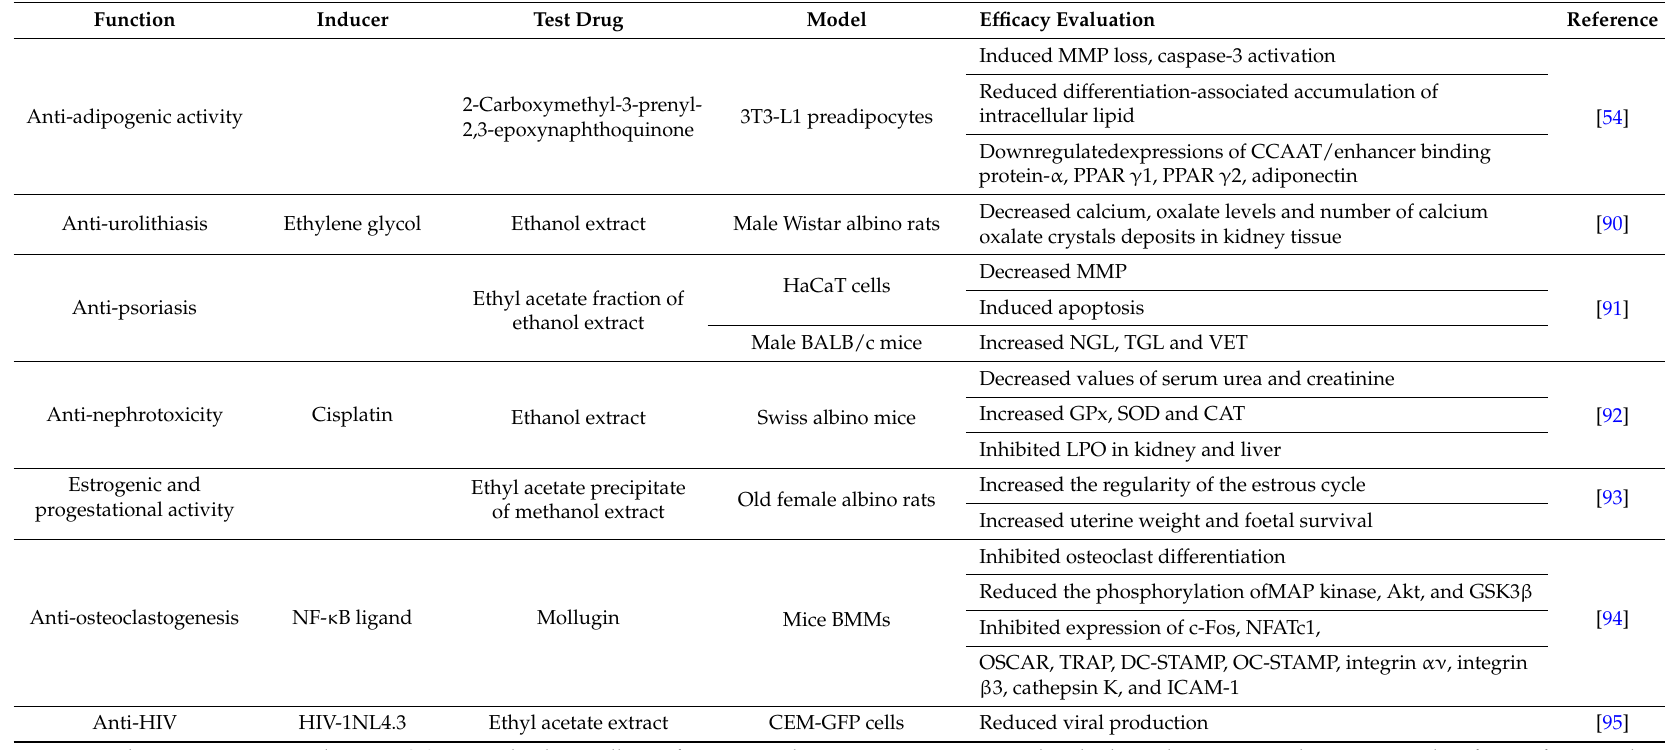
Table 2. Other functions of Rubiae Radix et